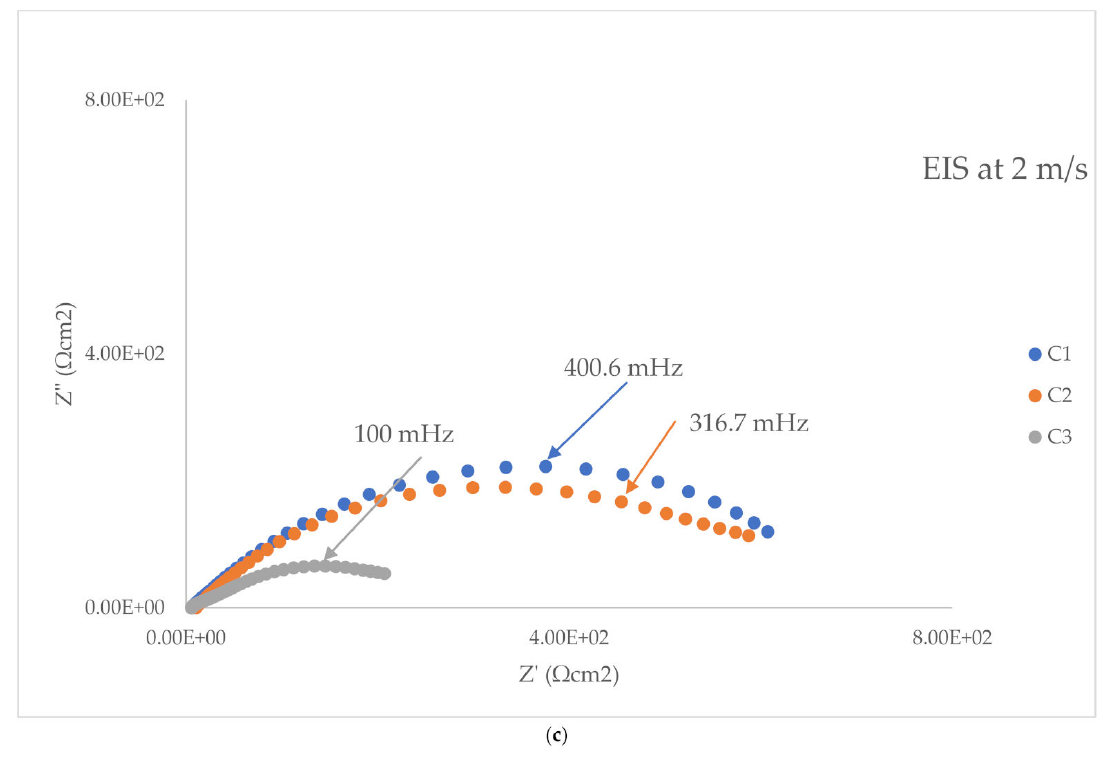
Figure 5. EIS Nyquist plots ( a ) 0 m/s, ( b ) 1 m/s, ( c ) 2 m/s.